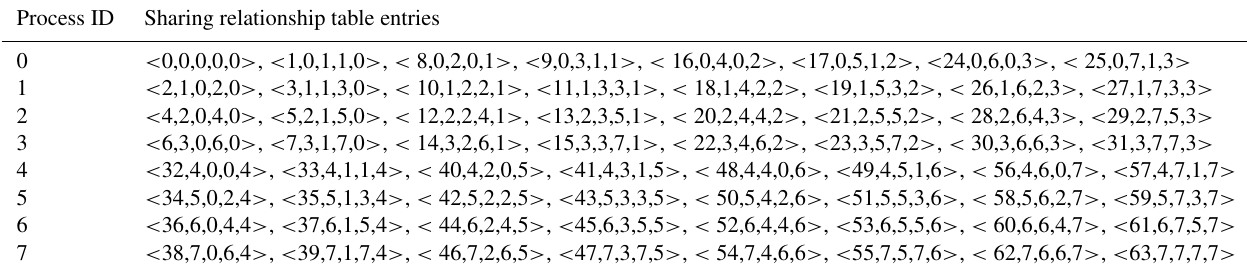
Table 5. The SRT entries distributed in the src component model after rearranging the SRT in Table 4. Process ID Sharing relationship table